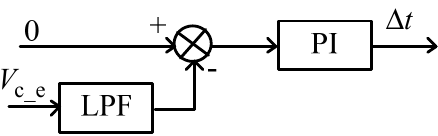
Figure 7. Diagram of capacitor voltage balancing strategy.